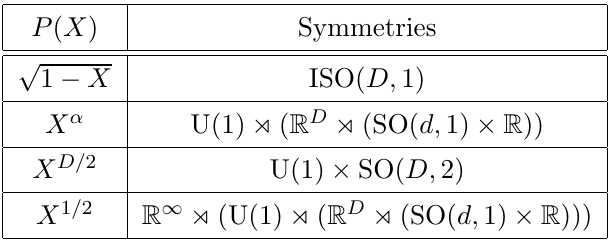
Table 1 . All interacting, Poincar(cid:19)e-invariant, shift-symmetric theories with enhanced symmetry in D = d + 1 spacetime dimensions, to leading order in derivatives. See the end of section 2.5 for a discussion of possible